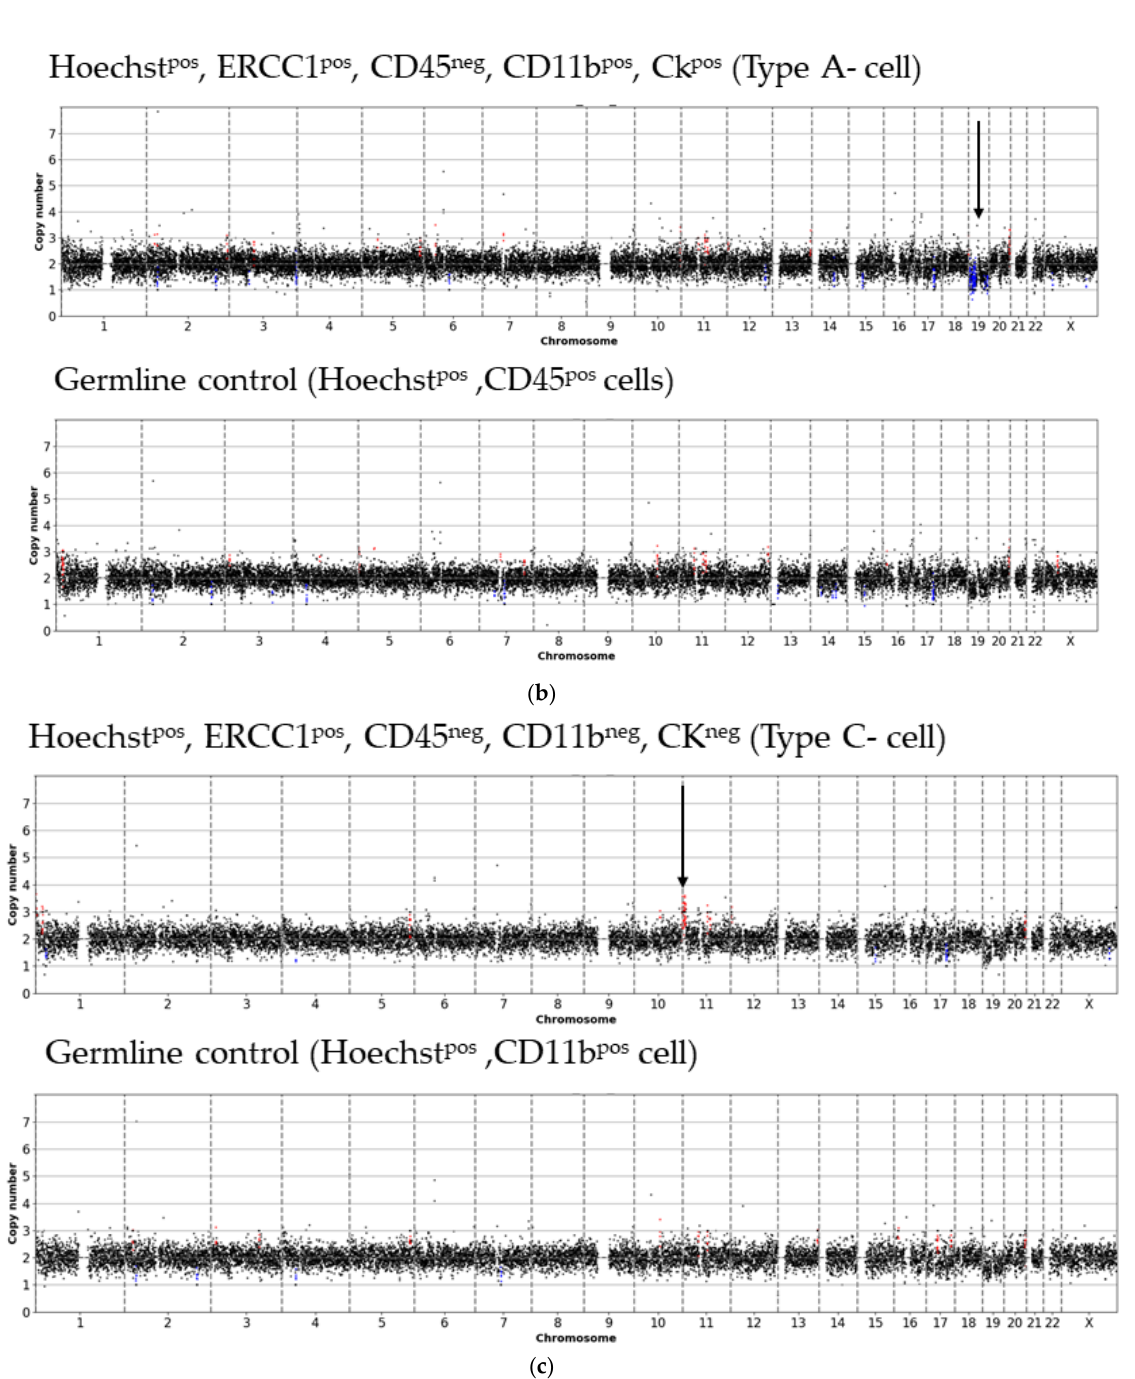
Figure A6. Three CN profiles with single spot CNAs from three different patients. ( a ) Patient 1 with a single spot CNA at chromosome 16 in a Type A- cell, compared to the matched germline CN profile with no aberrations. ( b ) Patient 6 with a single spot CNA at chromosome 19 in a Type A- cell, compared to the matched germline CN profile with no aberrations. ( c ) Patient 10 with a single spot CNA at chromosome 11 in a Type C- cell, compared to the matched germline CN profile with no aberrations. Due to low DNA quality of the CD45 pos cells, a Hoechst pos and CD11b pos cell was used as germline control.